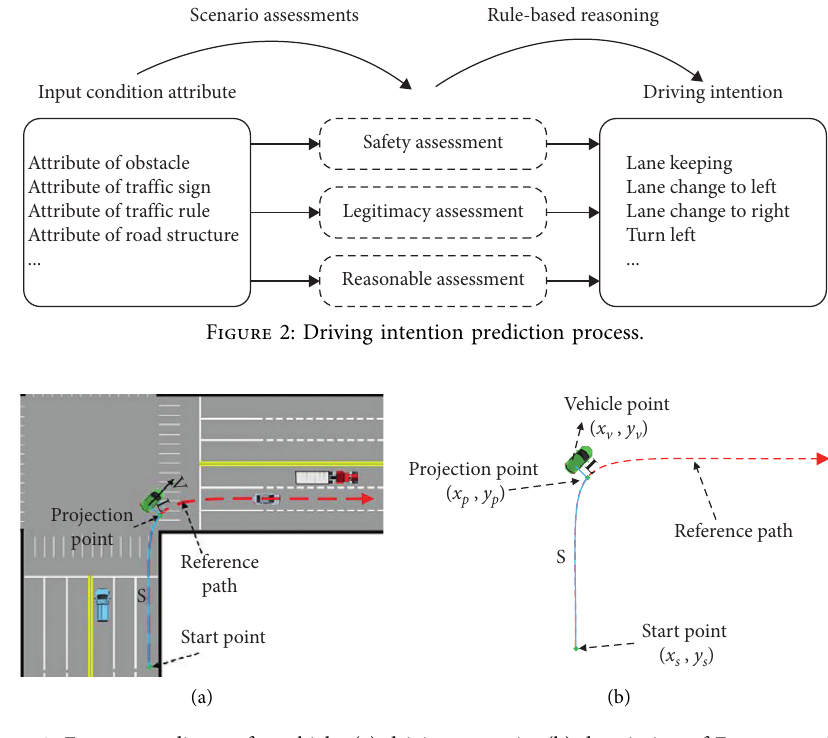
Figure 3: Frenet coordinate of a vehicle: (a) driving scenario; (b) description of Frenet